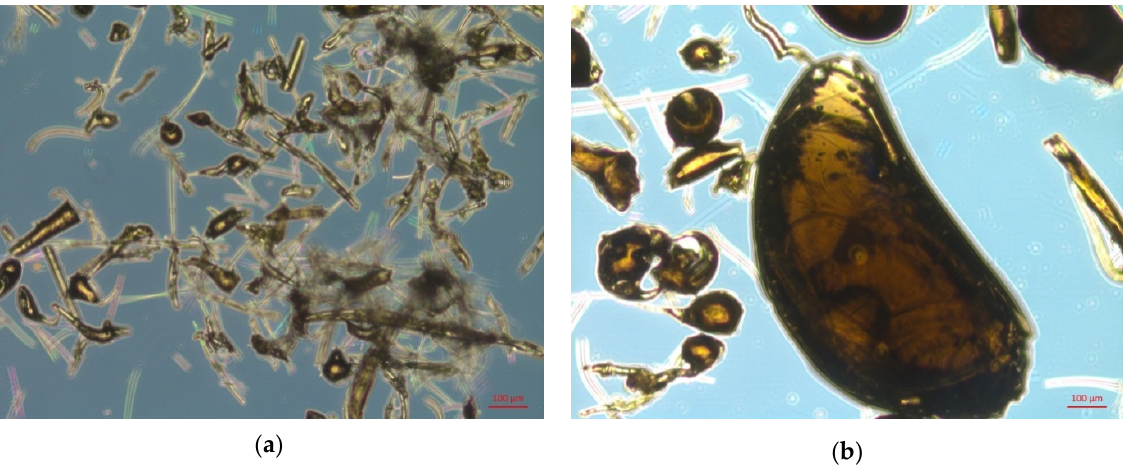
Figure 7. Basalt at a specific surface area of 500 m 2 /kg: ( a ) total TFM particles mass; ( b ) TFM beadlets.